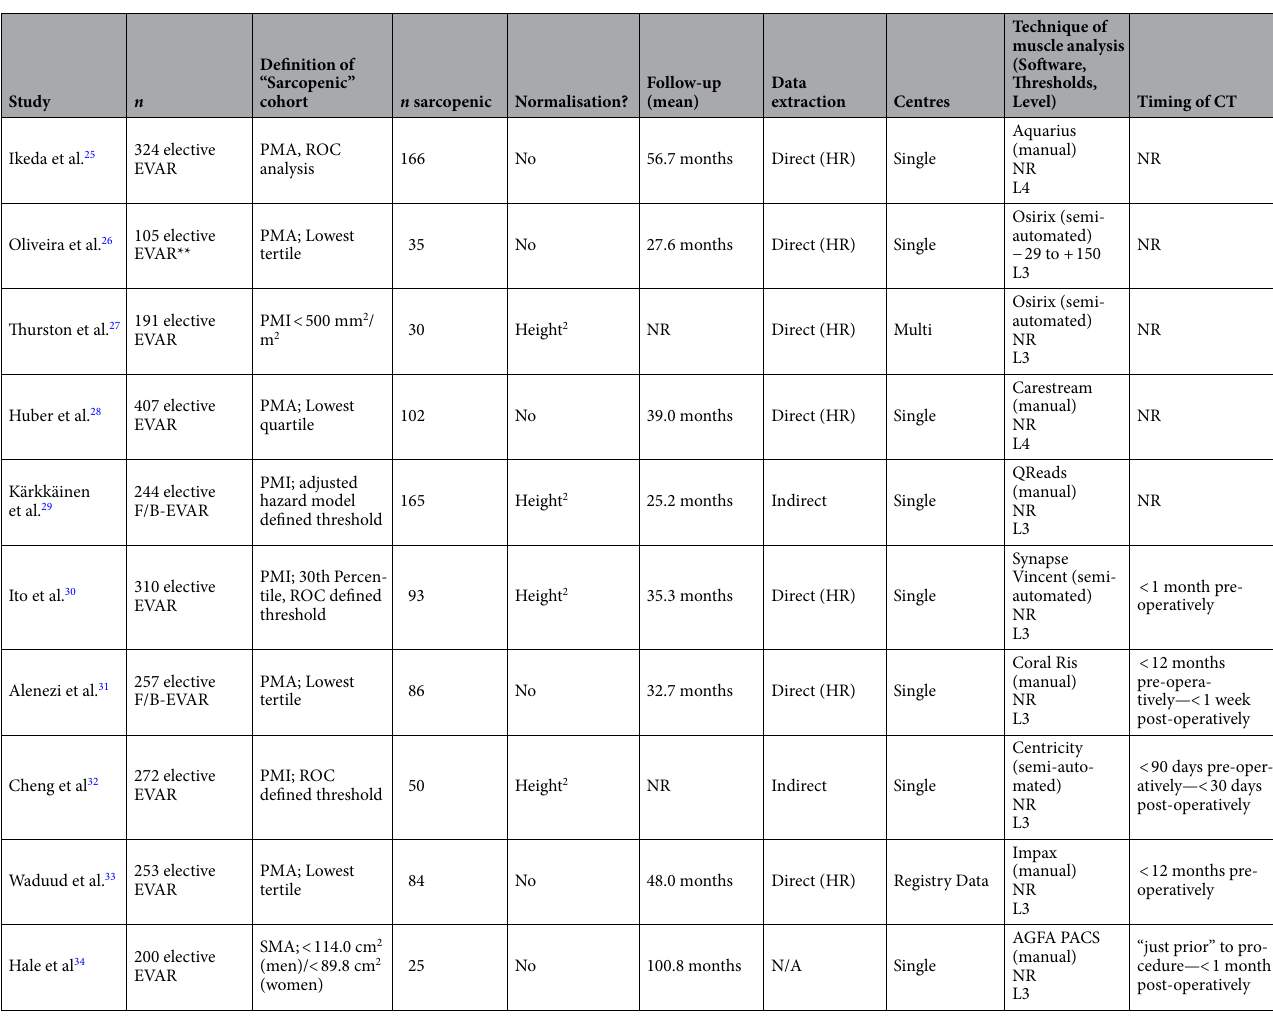
Table 1. Studies included in the final review of the prognostic effect of radiological sarcopenia in patients undergoing EVAR and F/B-EVAR. NR not reported, HR hazard ratio. **Excluded female patients.